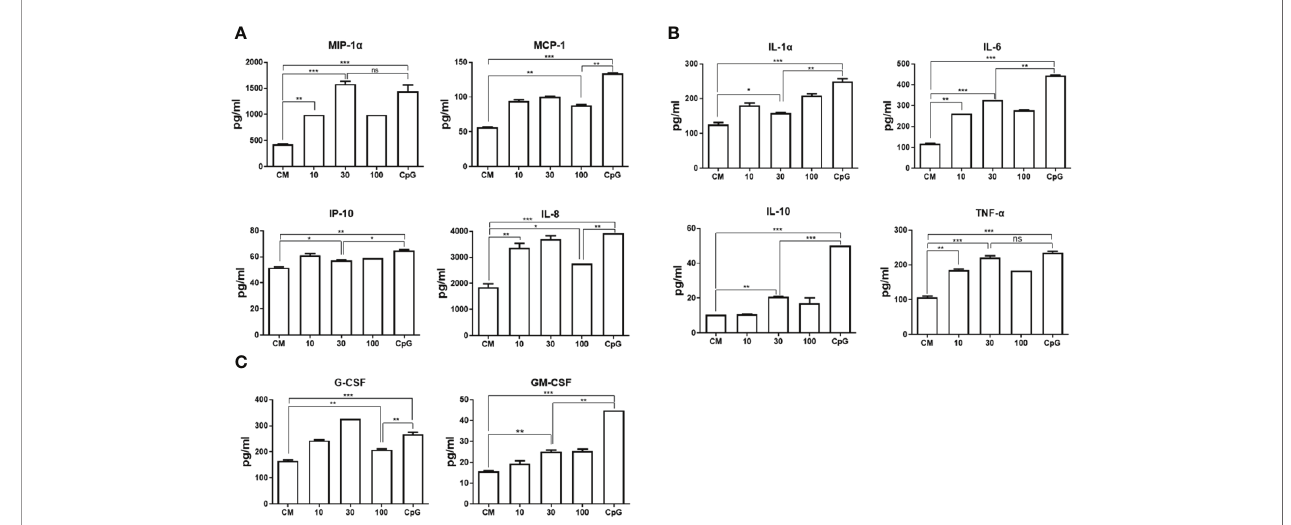
FIGURE 3 | DRibbles-induced chemokines, cytokines and hematopoietic growth factors production by human B cells. The puri fi ed human B cells were cocultured with various concentrations of HepG2.2.15 DRibbles (0, 10, 30, or 100 m g/ml) or CpG (10 m M) for 72 h, the supernatants were harvested for examination of chemokines (A) , cytokines (B) and hematopoietic growth factors (C) production by multiplex biomarker immunoassay. CM indicated complete medium. The data represent three separate experiments from three different healthy donors. ns, P > 0.05, * p < 0.05, ** p < 0.01, *** p <